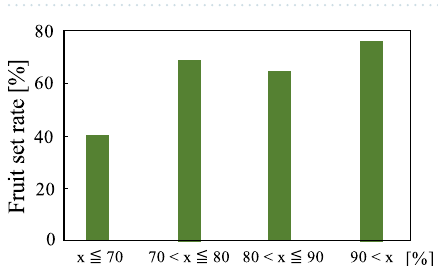
Figure 10. Fruit setting rate for each type of flower shape.